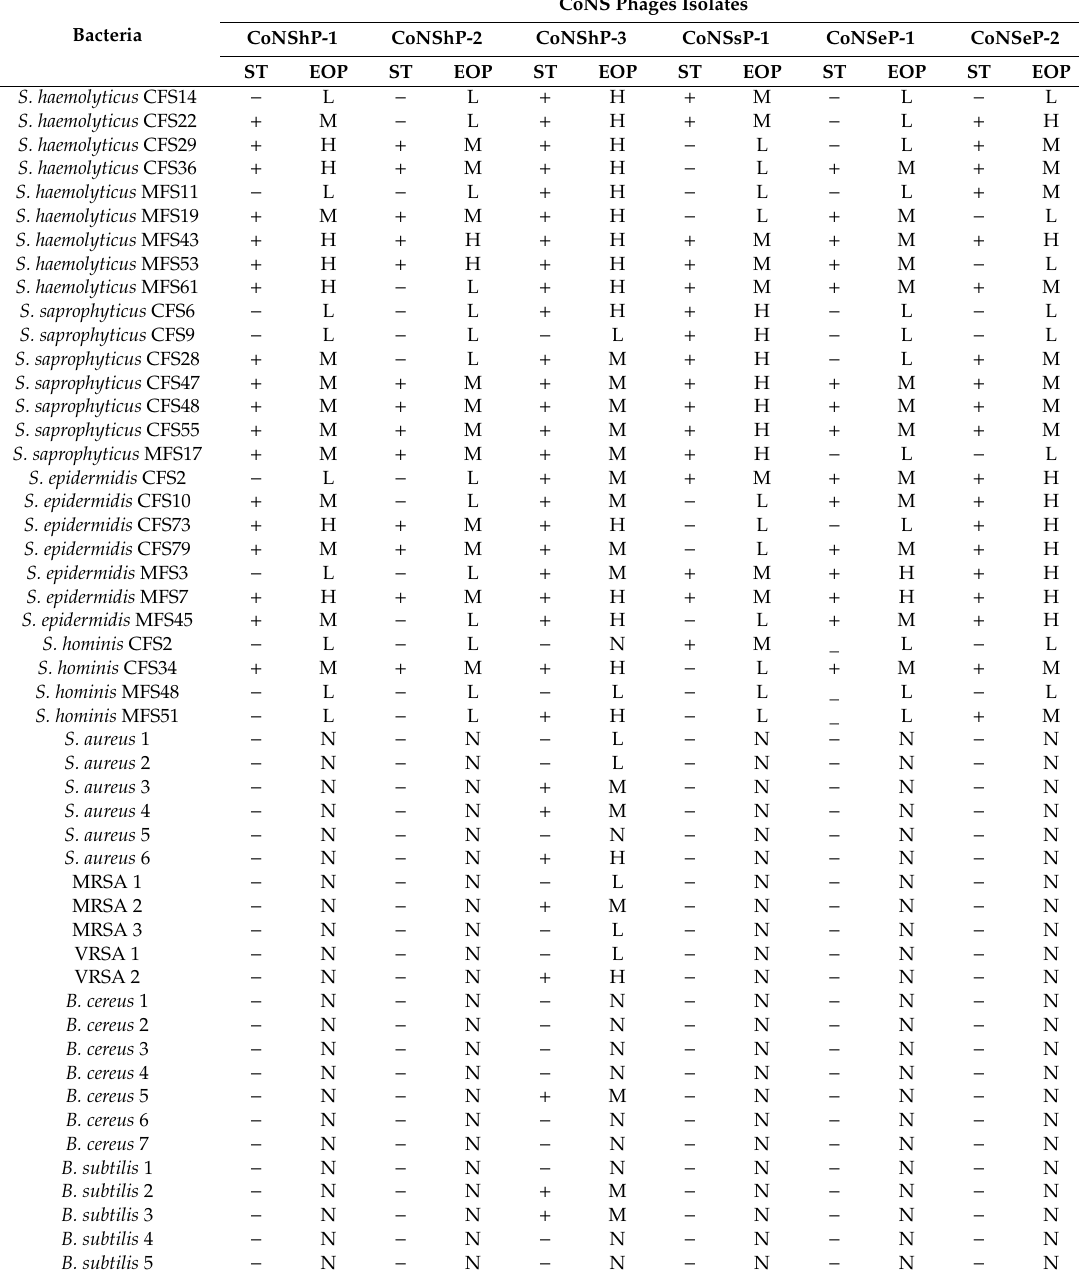
Table 2. Host Range and EOP Patterns of CoNS Isolated